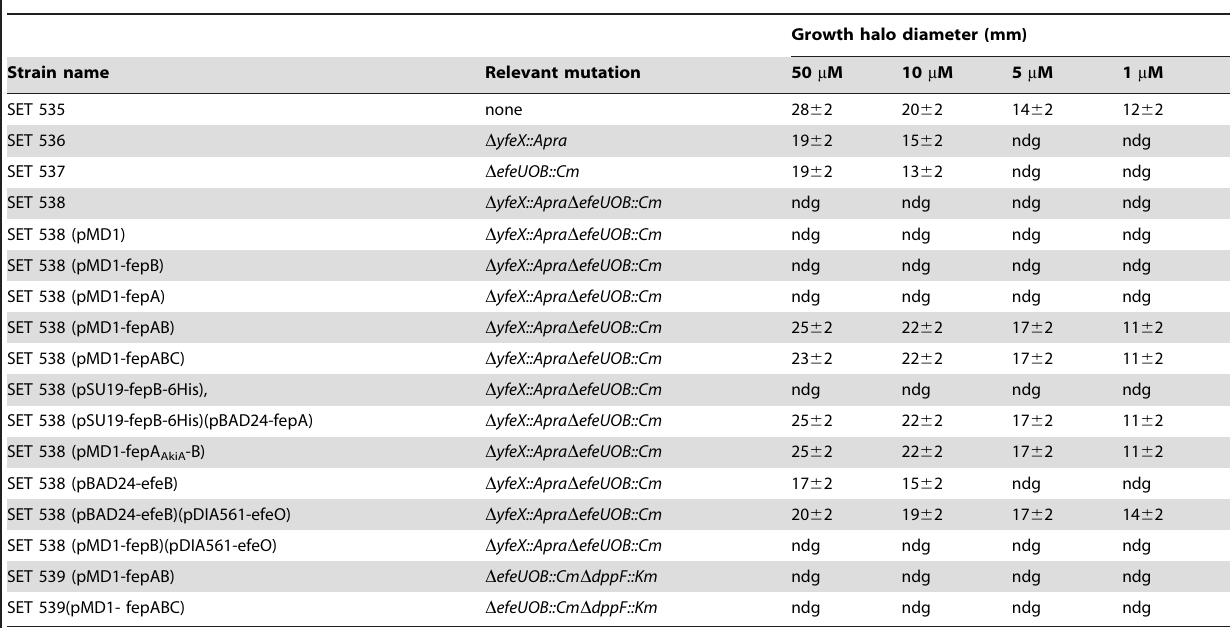
Table 3. FepABC role in heme acquisition.